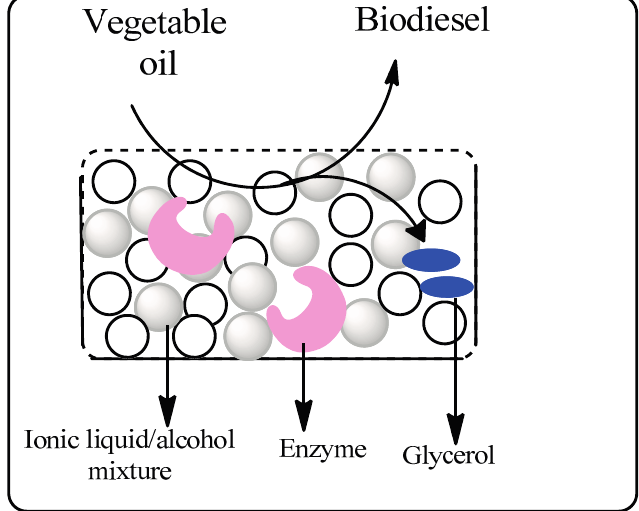
Figure 4. Lipase-catalyzed production of biodiesel in a biphasic ionic liquid-soybean oil system with concomitant separation of the glycerol by-product